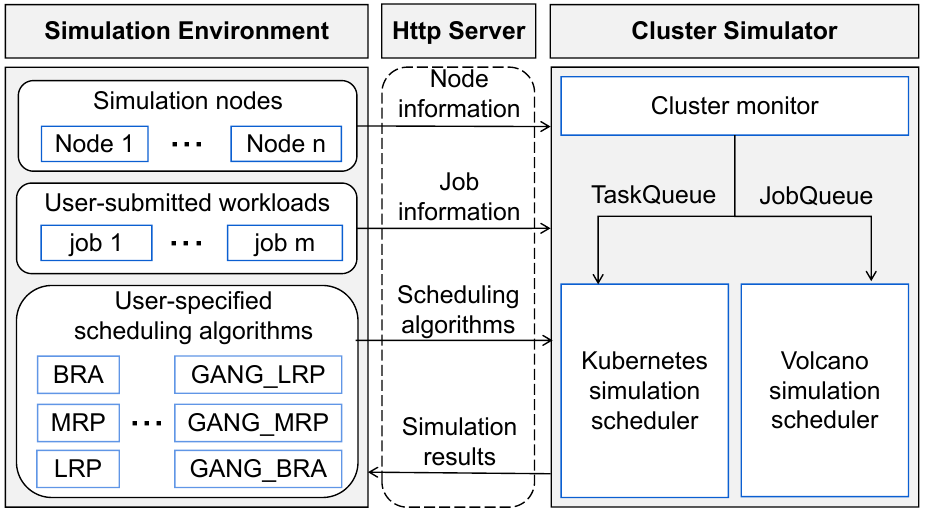
Figure 3. Overview of proposed cluster